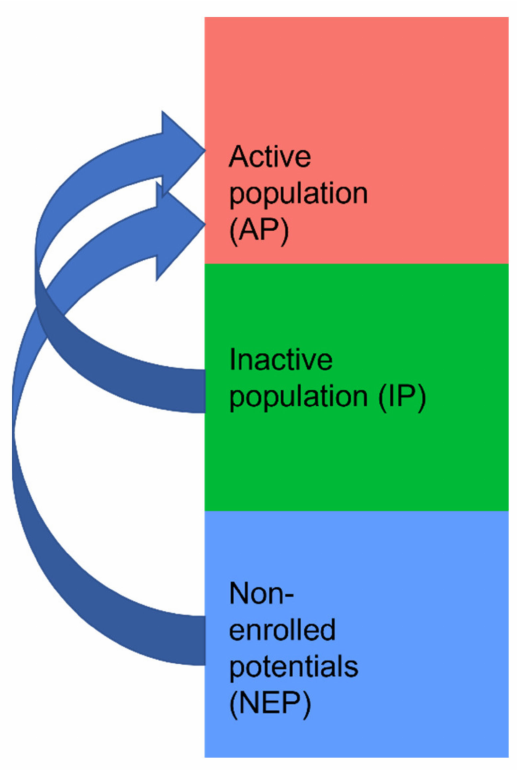
Figure 11. Populations that were compared for the Reach